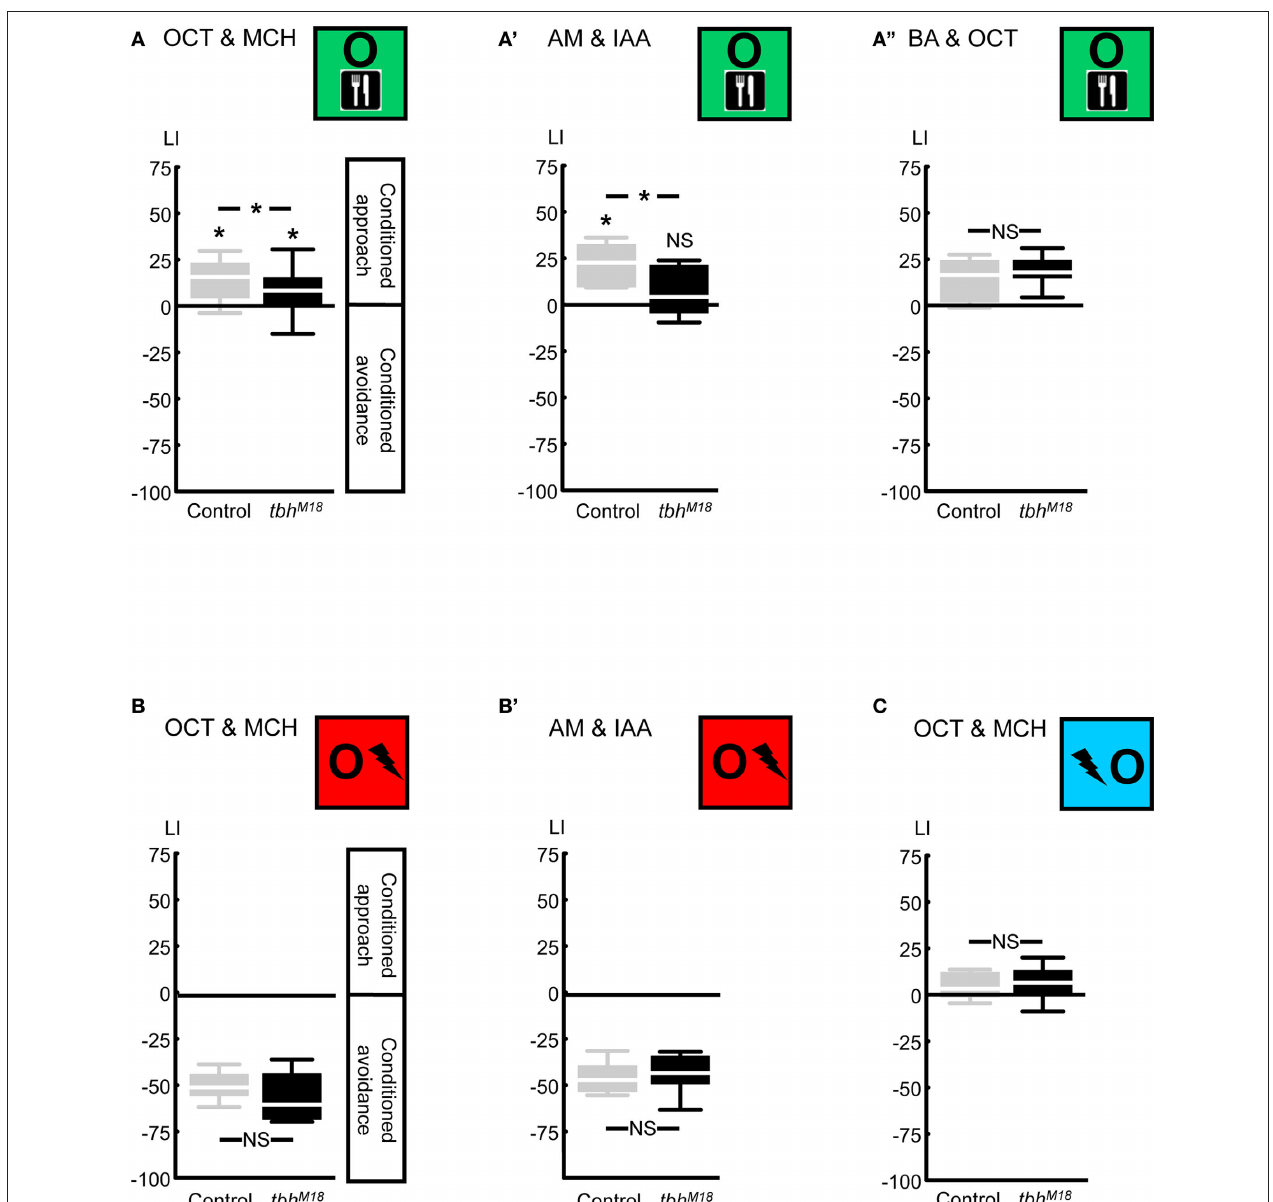
FiGuRe 6 | Compromising octopamine biosynthesis using the T β H mutant. We used the tbh M18 mutant, which has reduced or no octopamine. When the odors 3-octanol (OCT) and 4-methylcyclohexanol (MCH) were used, reward learning was partially impaired (A) . Using the odors n -amyl acetate (AM) and isoamyl acetate (IAA) revealed complete lack of reward learning in the tbh M18 mutant (A ′ ) . When the odors OCT and benzaldehyde (BA) were used, tbh M18 mutant was intact in reward learning (A ′′ ) . A modified punishment learning procedure, which was identical to reward learning, except that the shock pulses were replaced by sugar presentation, revealed no impairment in the tbh M18 mutant, when either the odors OCT and MCH